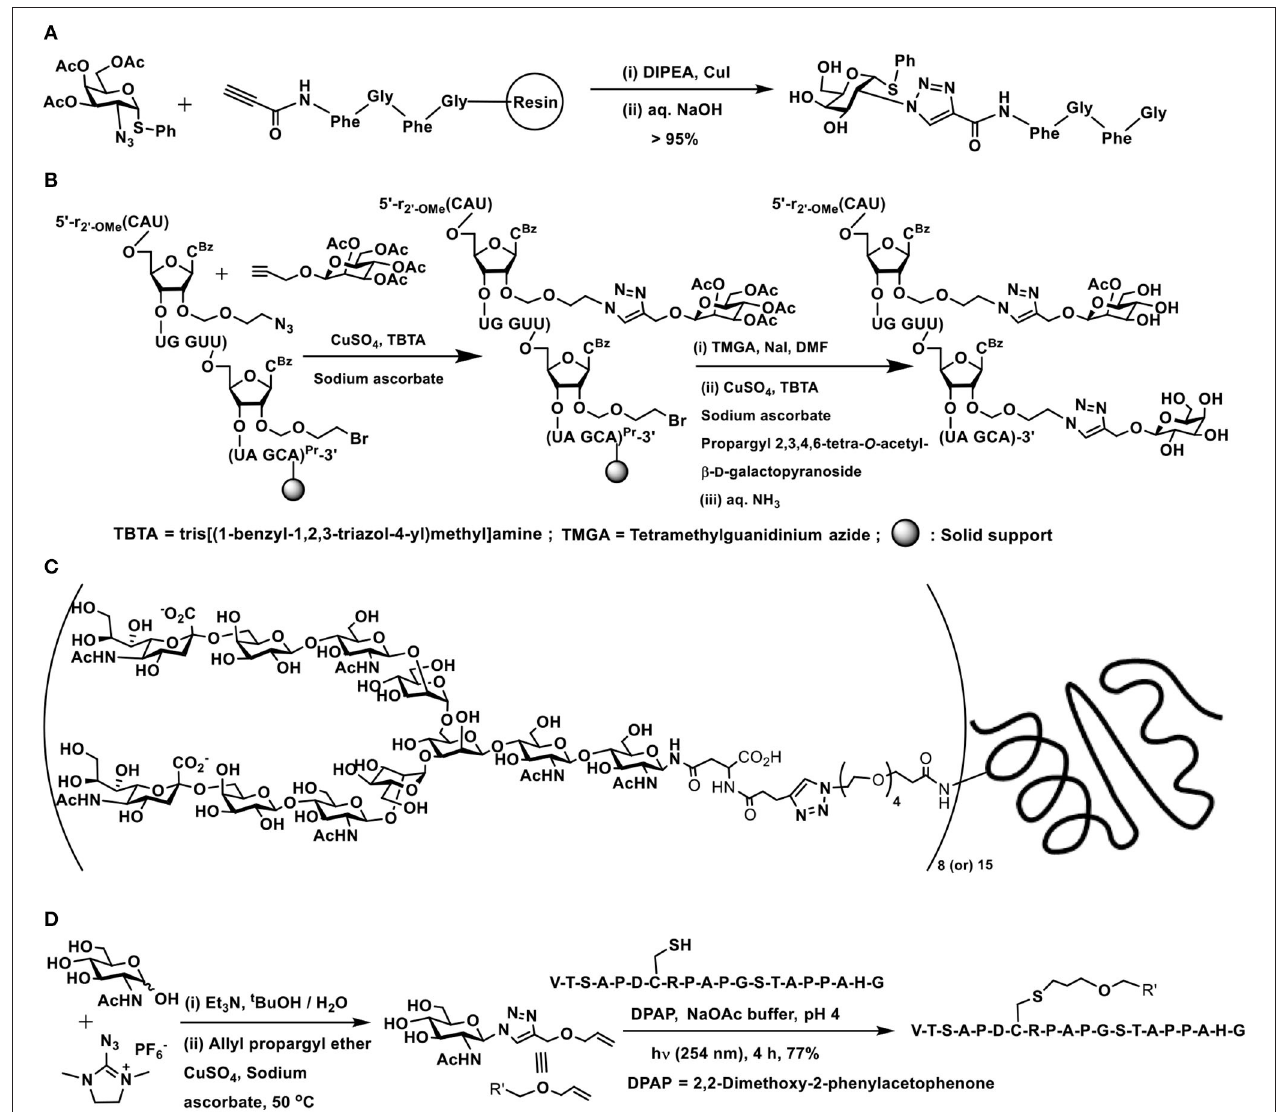
The double conjugation method has been demonstrated in order to secure target glycopeptides in the case of anti-HIV peptide drug enfuvirtide, which is a 36 amino acid residue synthetic peptide. In order to improve the therapeutic potential of the drug, a thia-Michael reaction by maleimide-tethered glycosides was performed, for which the peptide was modified with cysteine residues at N- and C-terminals. Maleimide-tethered glycosides, in turn, possessed the triazole-linker linking the maleimide segment with glycoside segment intercepted further with ethylene glycol spacer ( Scheme 12A ). In this manner, chosen glycoside could be conjugated to both the termini of the peptide (Cheng et al.,